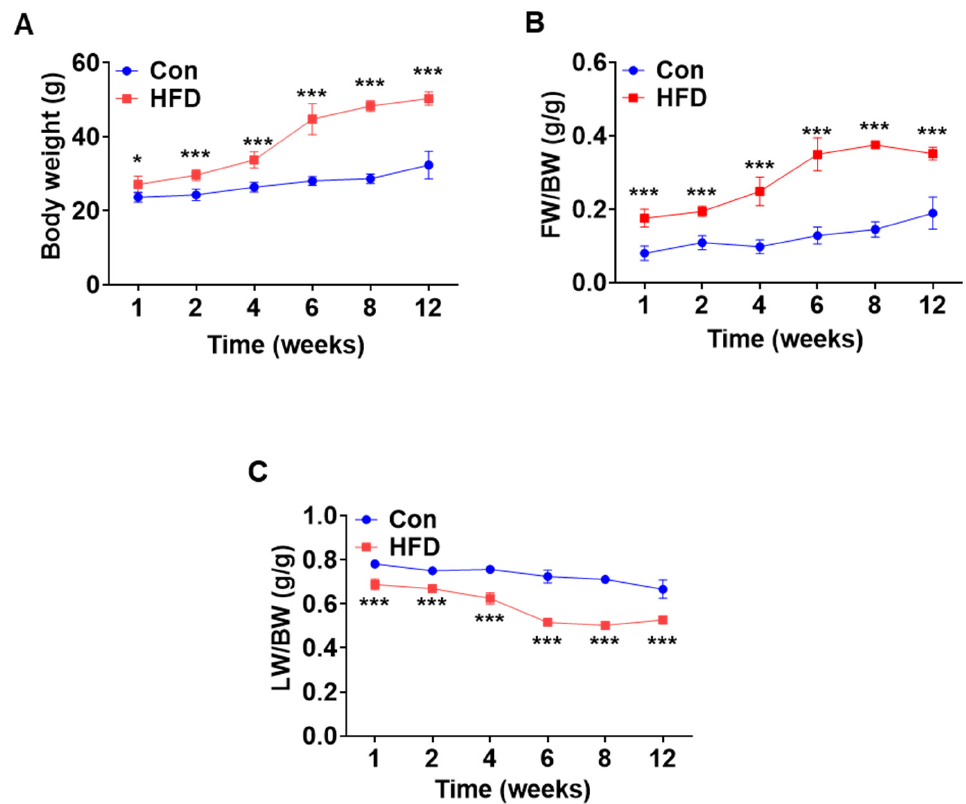
Figure 1. High-fat diet induced pre-diabetes and diabetes mellitus mouse model. Normal mice were fed either chow diet or HFD for 12 weeks ( n = 5). ( A ) Changes in body weight over a period of 12 weeks. ( B , C ) Time course of changes in fat mass and lean mass. * p < 0.05 and *** p < 0.001 Control vs. HFD-fed mice at the respective weeks. HFD: high-fat diet.